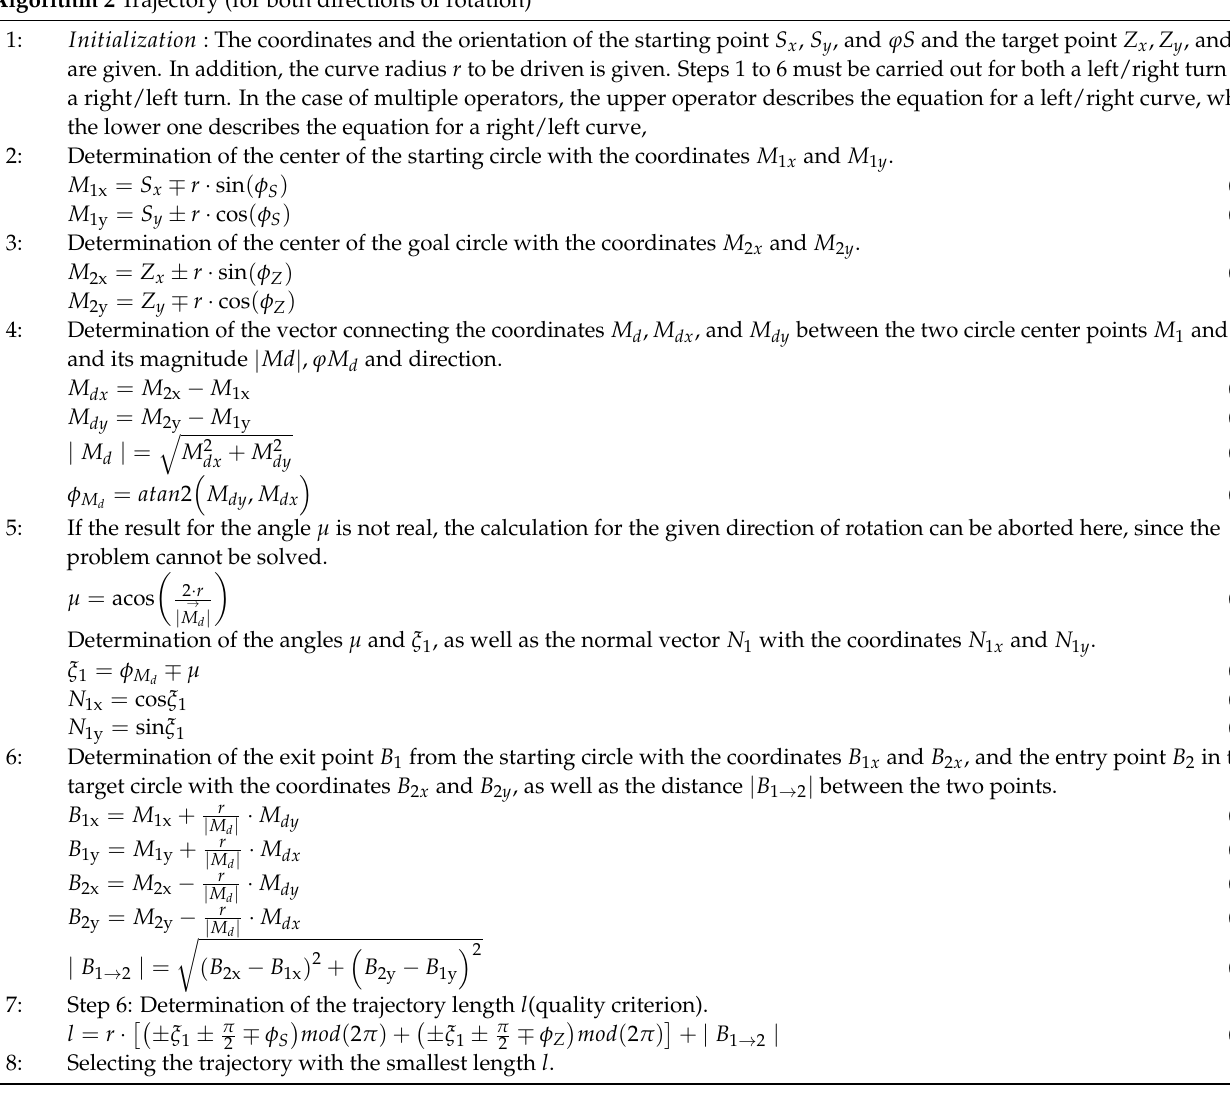
Algorithm 2 Trajectory (for both directions of